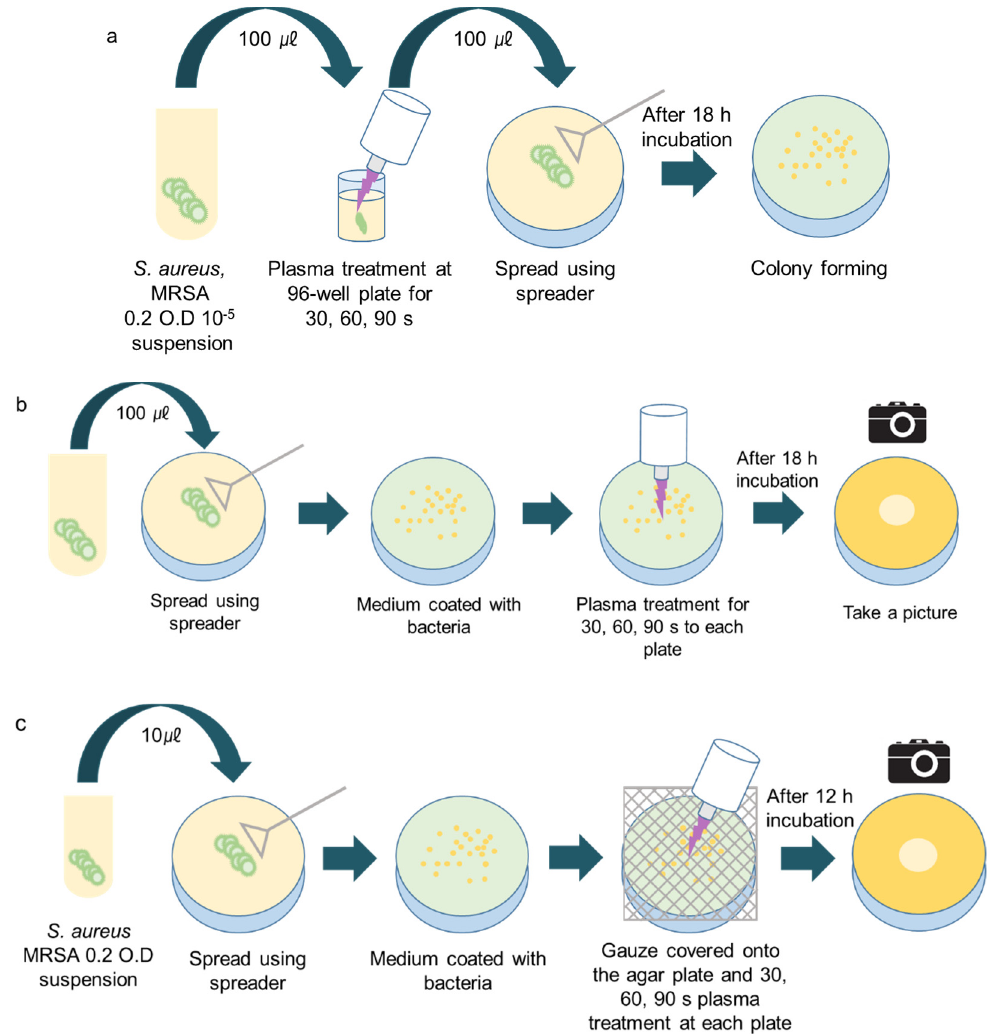
Figure 2. Schematic of CAPMP treatment of bacteria ( a ) in the suspension, ( b ) spread onto the agar plate, or ( c ) a dressing gauze covering the LB agar plate.